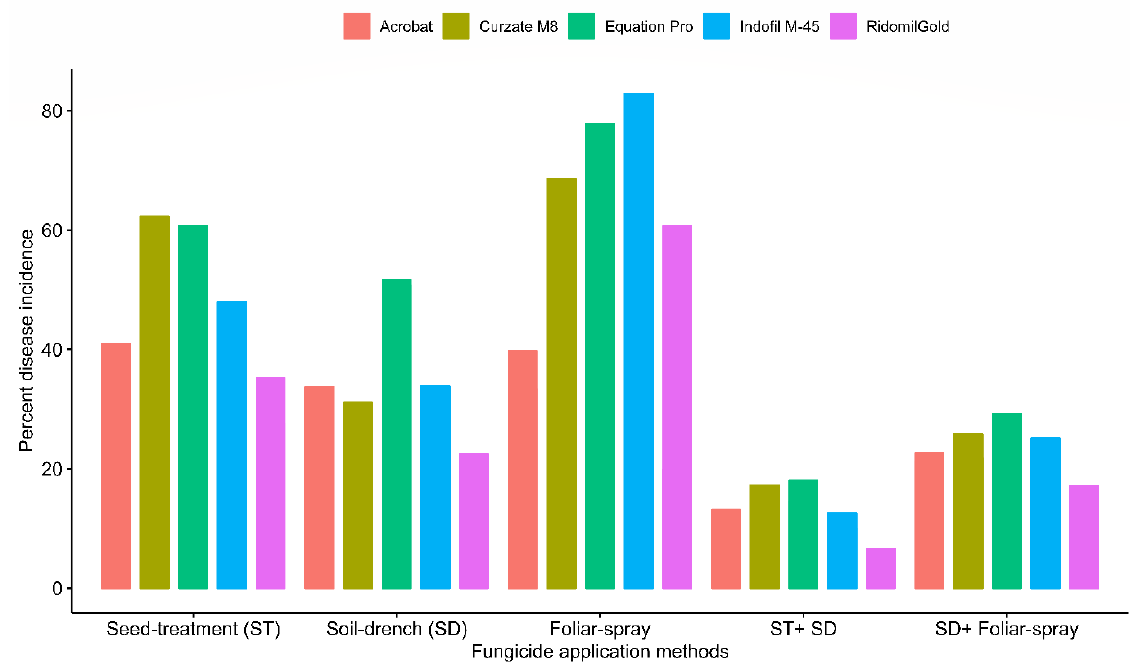
Figure 4. Evaluation of fungicide efficacy and application methods in controlling Phytophthora blight of pigeonpea seedlings on susceptible ICP 7119